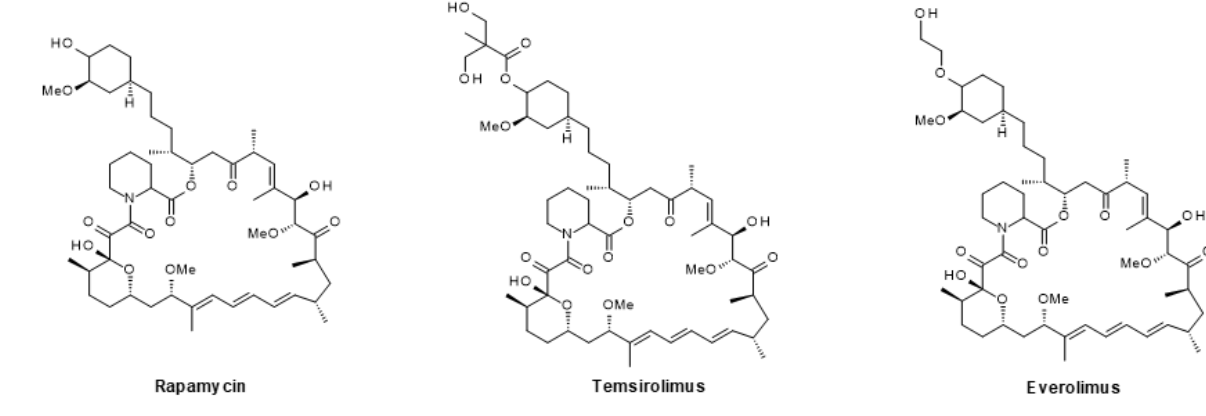
Figure 8. Macrocyclic allosteric mTOR inhibitors.